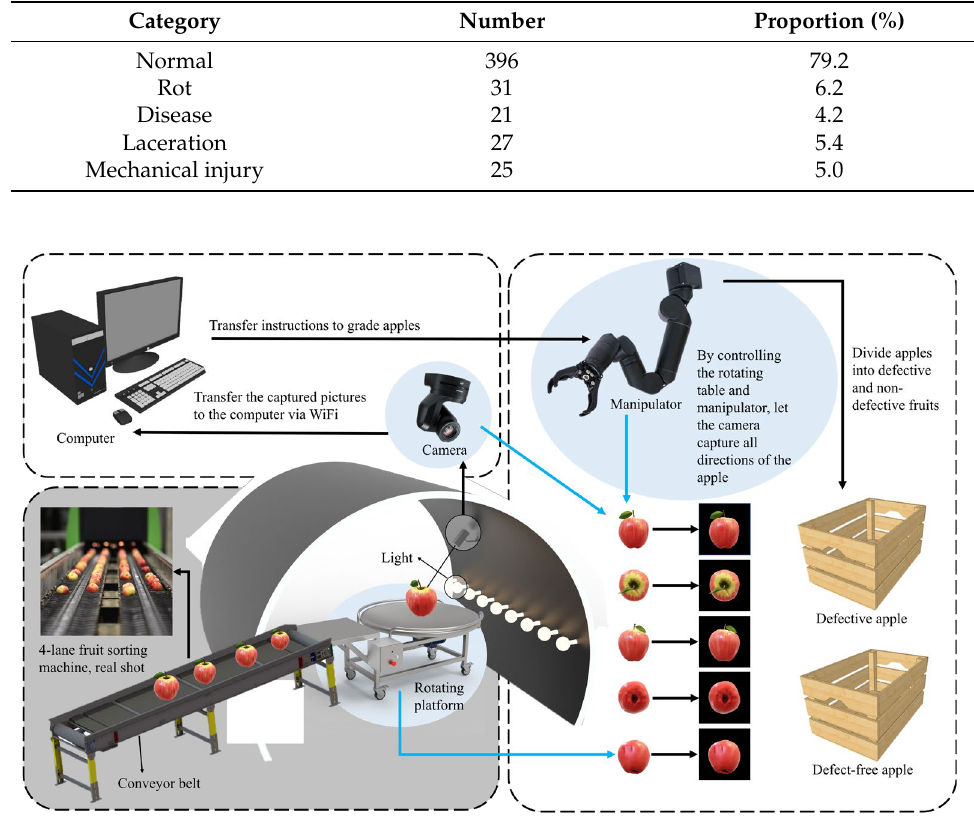
Table 2. The data distribution of the training set.